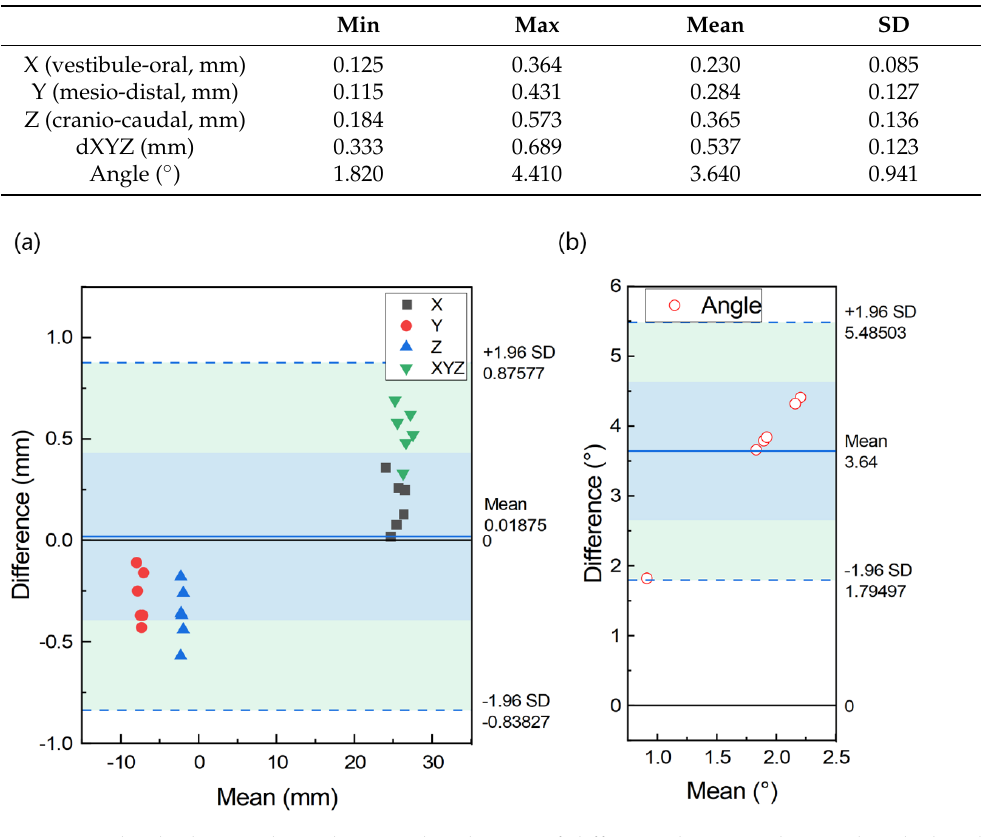
Figure 5. Box plot of deviation on axes (For all variables with the same letter, the difference is not statistically significant ( p > 0.05). Different letters between groups represents significantly different ( p < 0.05)).